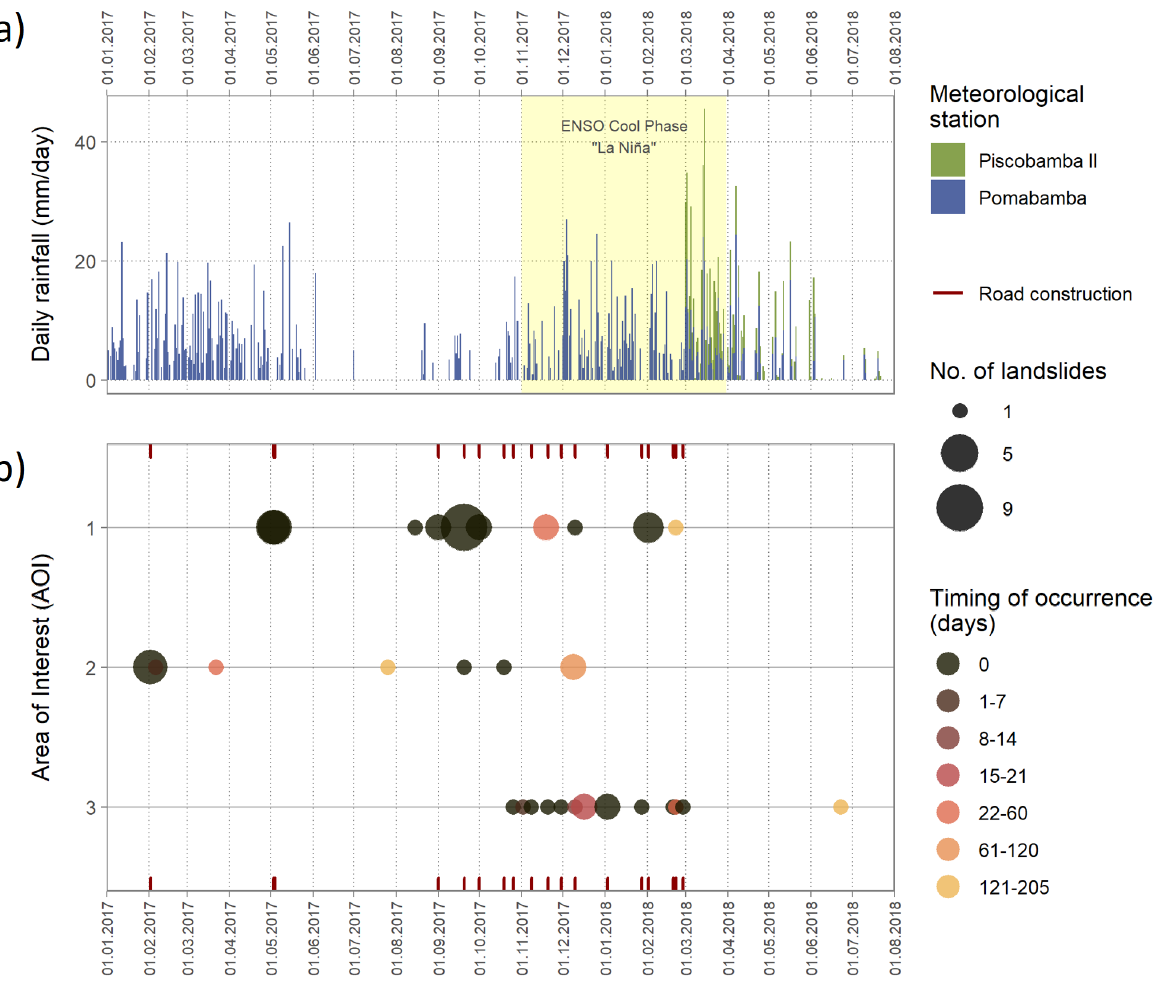
Figure 5. Rainfall and the occurrence of landslides in the three AOIs. a) indicates the daily rainfall recorded by the two closest SENAMHI meteorological stations, the ENSO Cool Phase “La Niña” period is highlighted in yellow. b) indicates the occurrence of landslides per AOI. The size of the circle represents the number of landslides, while the colour represents the time difference between landslide occurrence and road construction. The landslide occurrence and road construction dates refer to the first time the landslide or the new road, respectively, was observed on VHR imagery. Road construction dates are marked at the top and bottom of the